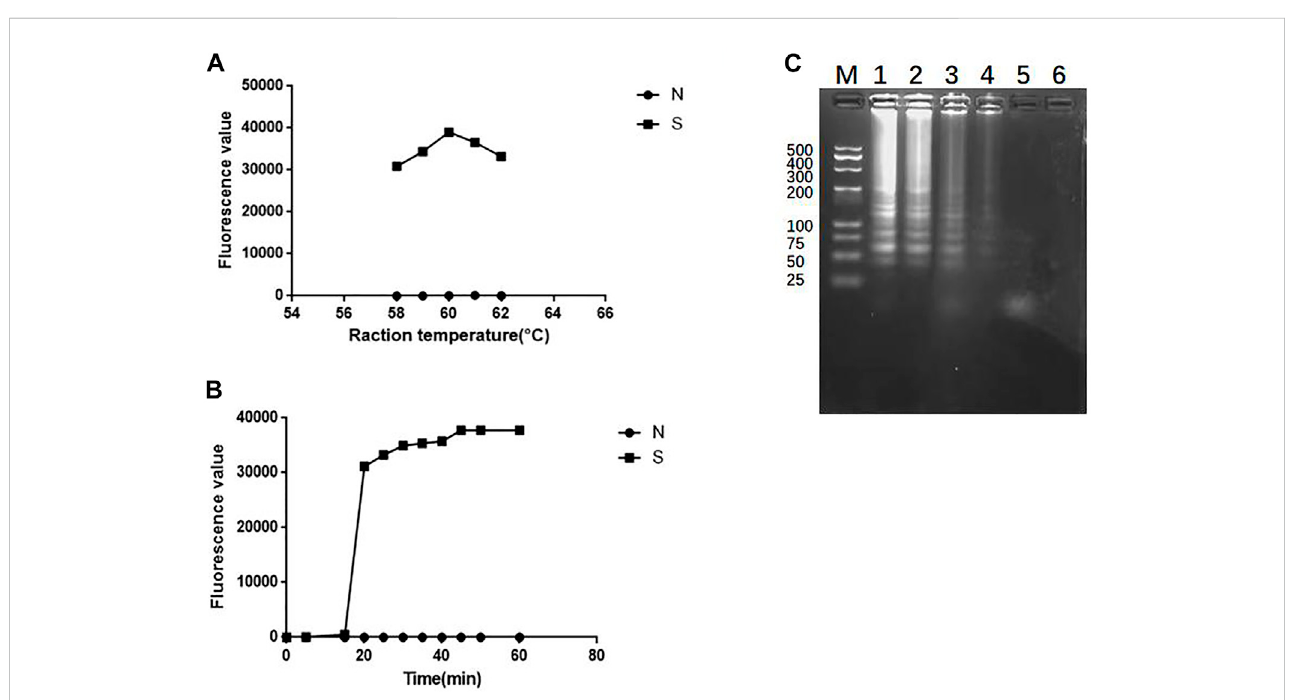
FIGURE 6 Optimize the reaction conditions of SEA. (A) Fluorescence values of standard strain of Klebsiella pneumonia at 58 ° C, 59 ° C, 60 ° C, 61 ° C and 62 ° C, respectively by SEA-ICTS; (B) Fluorescence values of parallel samples collected by SEA-ICTS every 5 min from 0 to 60 min at 60 ° C; (C) SEA product determined by 3% agarose gel electrophoresis. Lane M, DL 500 DNA marker. Lane 1, 35 min. Lane 2, 30 min. Lane 3, 25 min. Lane 4, 20 min. Lane 5, 15 min, Lane 6, negative